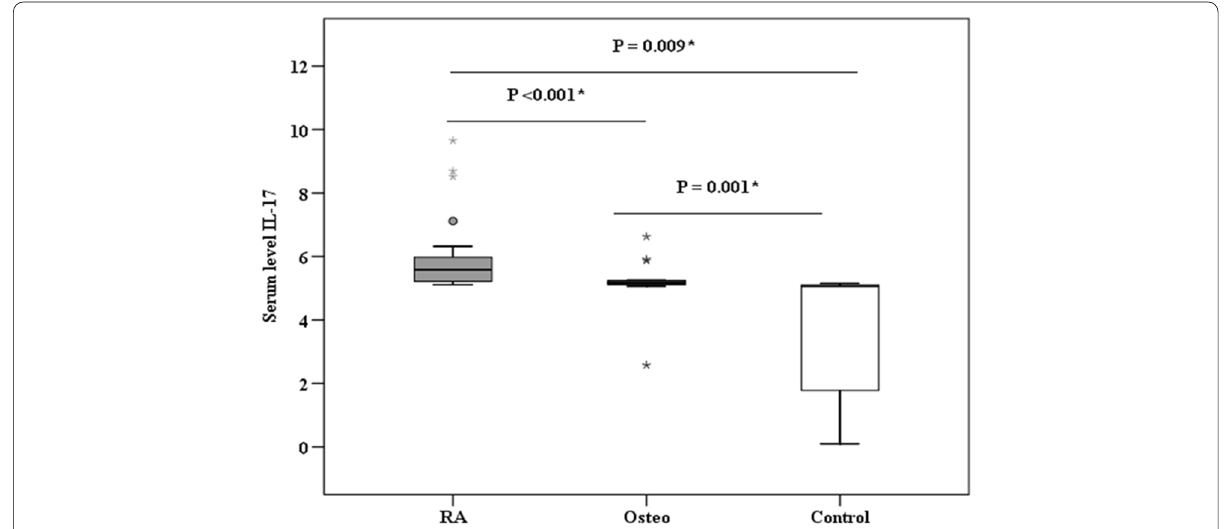
Fig. 1 Box plot graph comparing serum IL‑17 level (in pg/ml) in the three studied